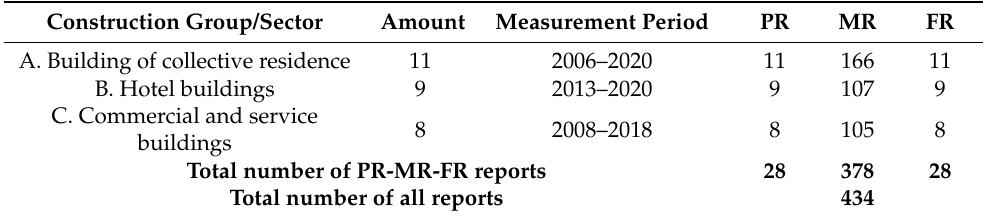
Table 2. Summary of the number of cumulative cost measurements in the BIS